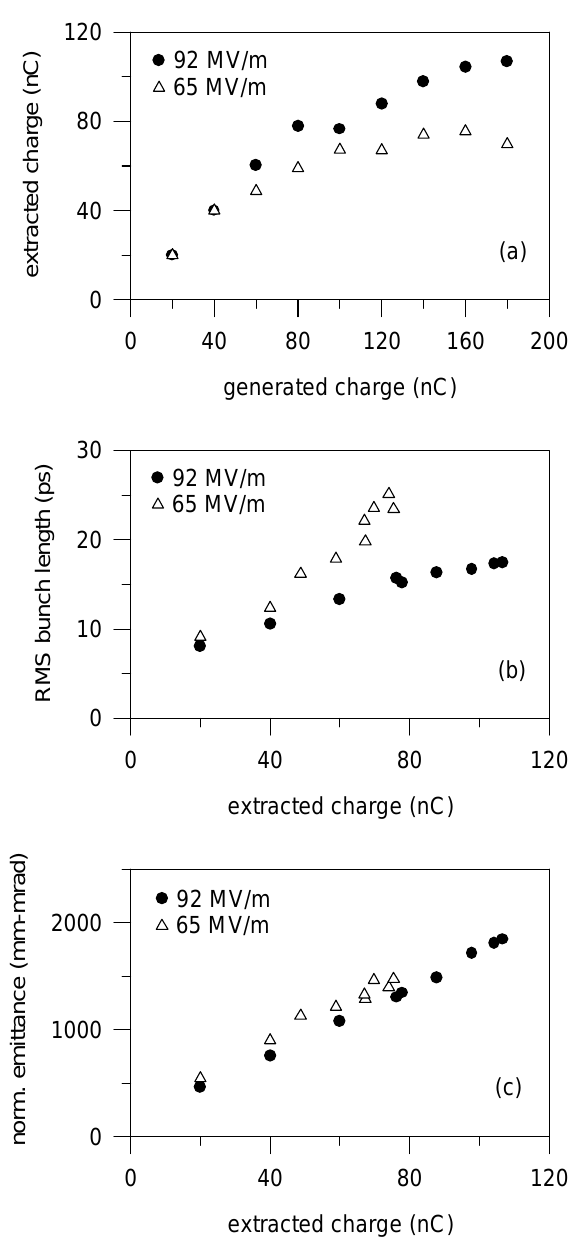
FIG. 8. Numerical simulation results comparing the perfor- mance of the electron gun with accelerating gradients of 92 and 65 MV (cid:121) m: (a) extracted charge as a function of the charge generated at the cathode surface; (b) RMS bunch length as a function of the extracted charge; (c) normalized emittance as a function of the extracted